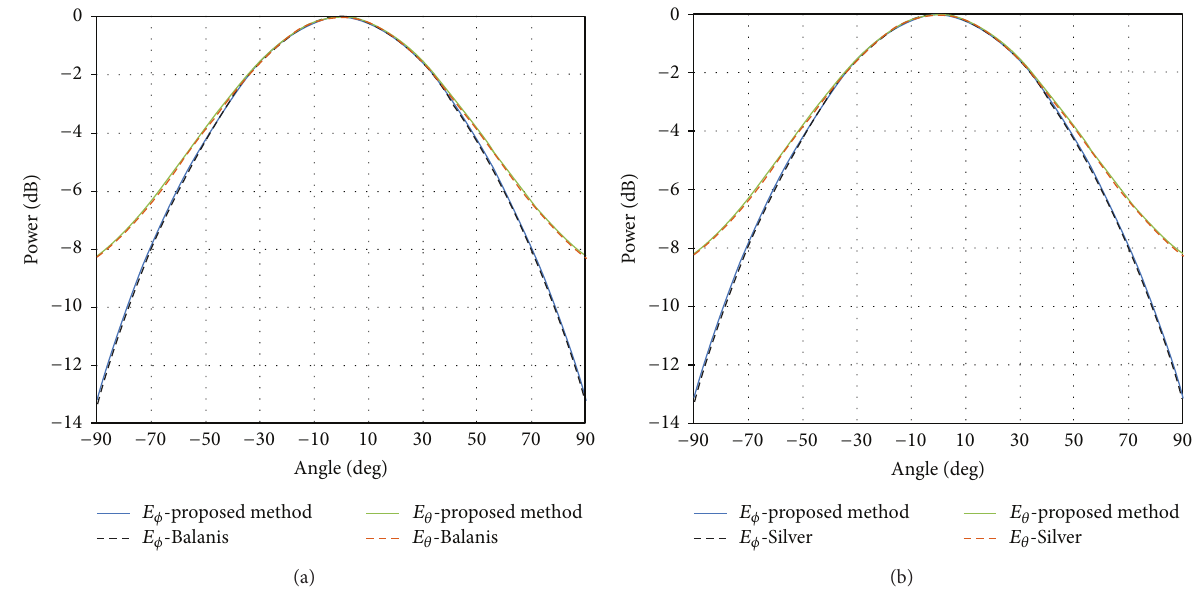
Figure 5: (a) Comparison of far field radiation patterns of circular waveguide obtained from [12] and proposed near field method. (b) Comparison of far field radiation patterns of circular waveguide obtained from [1] and proposed near field